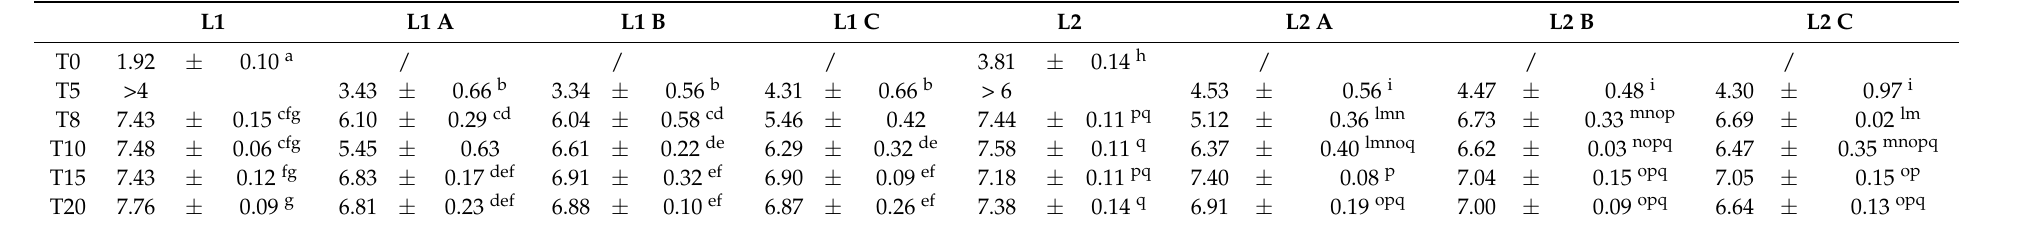
Table 2. The behavior of P. fluorescens (5026) in mozzarella cheese (L1: 2 Log CFU/mL and L2: 4 Log CFU/mL) in presence of CDH (A: 100 LOX-U/100L, B: 150 LOX-U/100L, C: 200 LOX-U/100L) during refrigerated shelf life (data are reported as the mean values ± standard deviation of Log CFU/g). The differences in microbial concentration observed over time were analyzed within the samples inoculated with the same initial concentration. Means with the same letter are not significantly